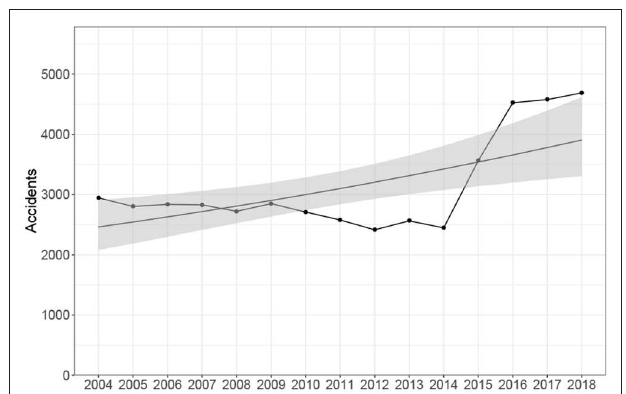
FIGURE 1 | Accident numbers from Zurich between 2004 and